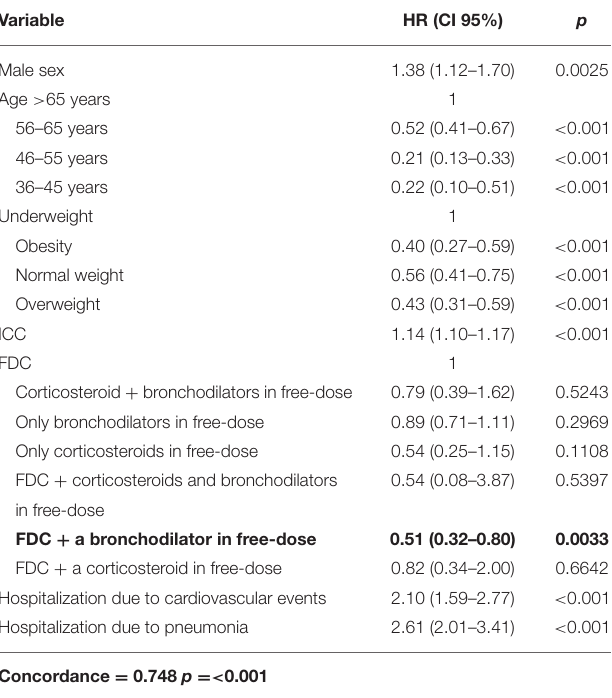
TABLE 3 | Estimated Hazard Ratio at a 95% Confidence Interval according to the Cox Proportional analysis model for the matched cohort from 2003 to 2015 ( n =